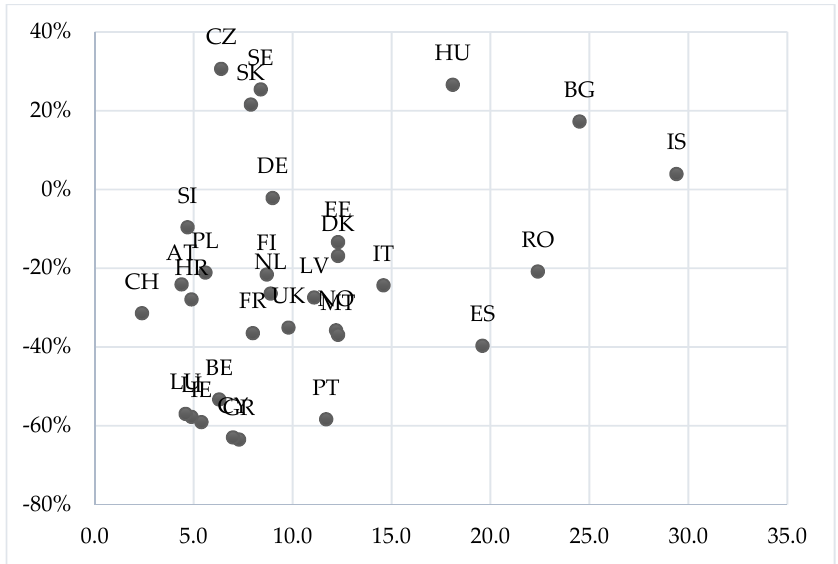
Figure 2. Percentages points of early school leavers (18 to 24 years) in rural areas in 2019 and relative change in percentage points 2010–2019 in percent. Source: Eurostat 2020, [edat_lfse_30].